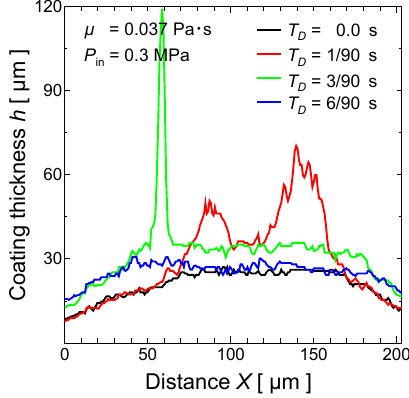
Figure 8. Coating thickness on a red line in Figure 7.